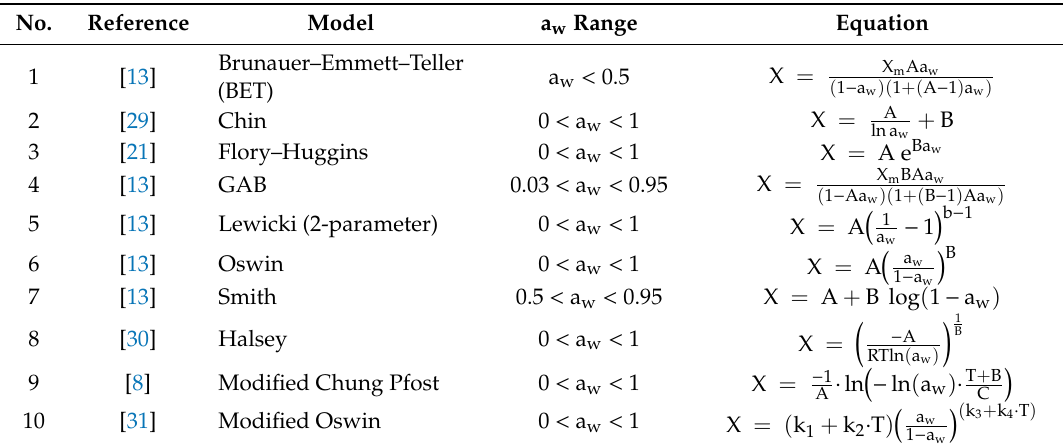
Table 1. Selected isotherm models for fitting experimental data. The monolayer water content (X m ) is assumed to be temperature independent and indicates the number of sorption sites available on the surface of the material. Di ff erent models are used to describe the moisture sorption isotherms (MSI) at di ff erent a w ranges (shown as “a w Range”) and model fitting was done with a subset of the data associated with the referenced a w